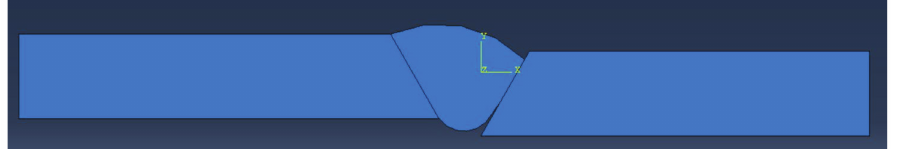
Figure 19. New numerical model geometry, including lack of fusion on the lower side of the welded